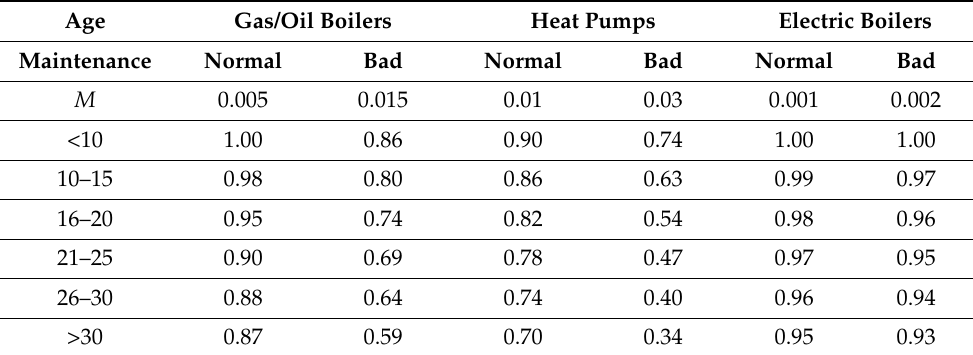
Table 1. Degradation coefficient as a function of appliance, maintenance and